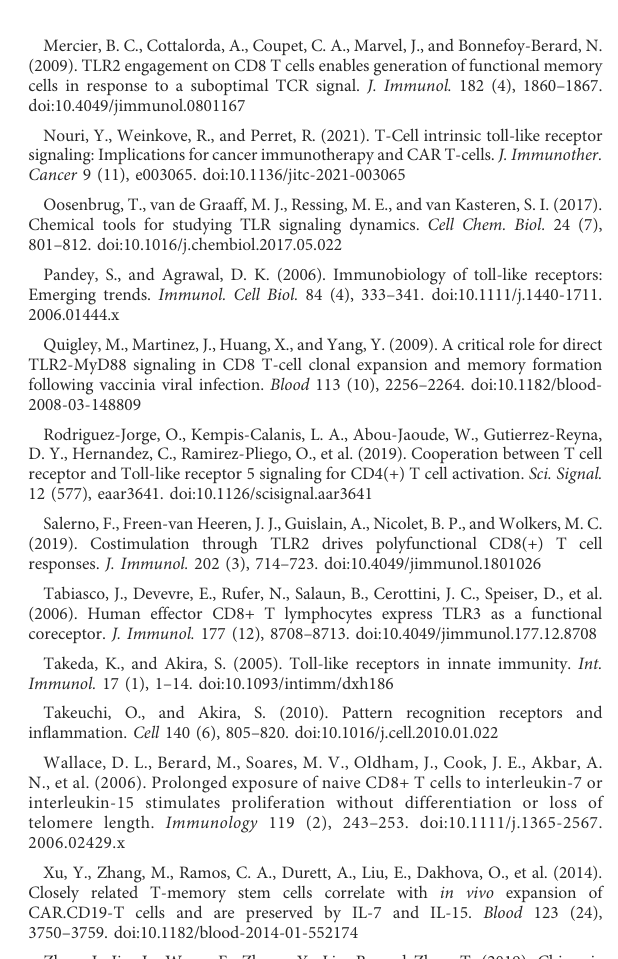
from the same source of blood-derived PD1+ CD8 + T cells in the presence or absence of TLR agonists were comparedfor their cell killing capability in the in vitro co-culture system, measured by real-time cell analysis (RTCA). Related to Figure 4C. SUPPLEMENTARY TABLE S1 Numbers of differentially regulated genes in blood-derived CD8 + T cells responding to TCR stimulation in the absence and presence of different combinations of TLR agonists. Related to Figure